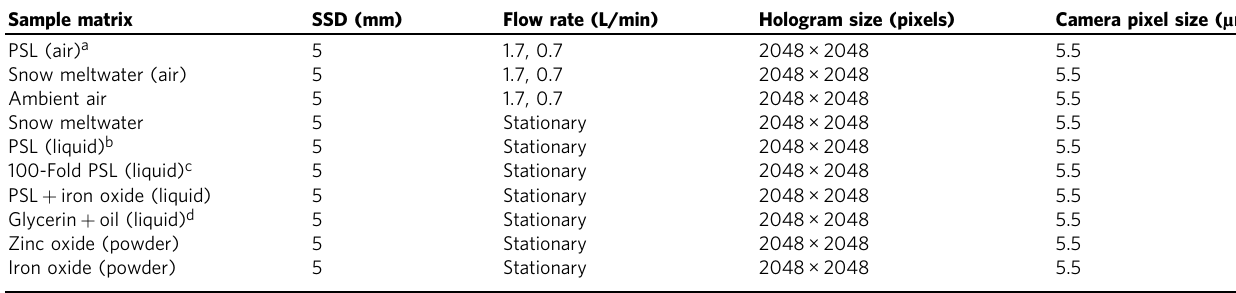
Table 1 Detailed experimental parameters for the matrices used. Sample matrix